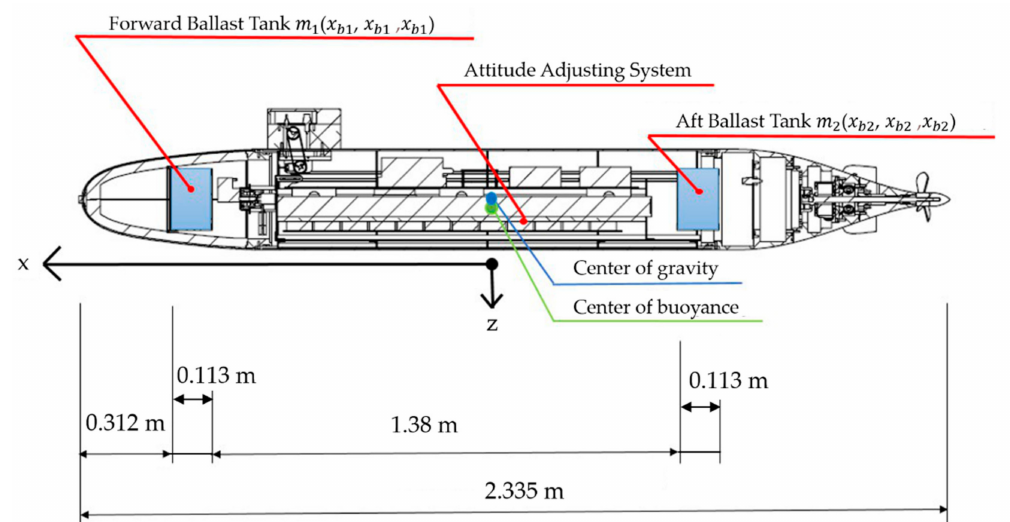
Figure 2. The configuration of ballast tanks and the attitude adjusting